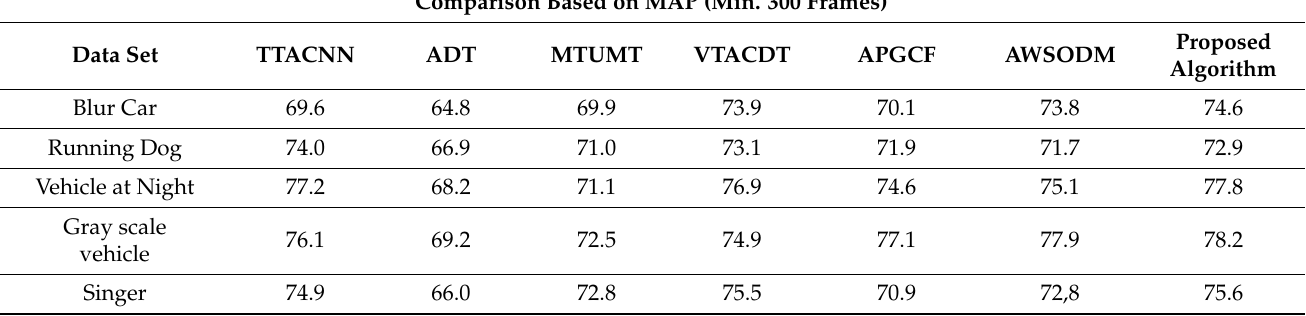
Table 4. Performance evaluation based on MAP. Comparison Based on MAP (Min. 300